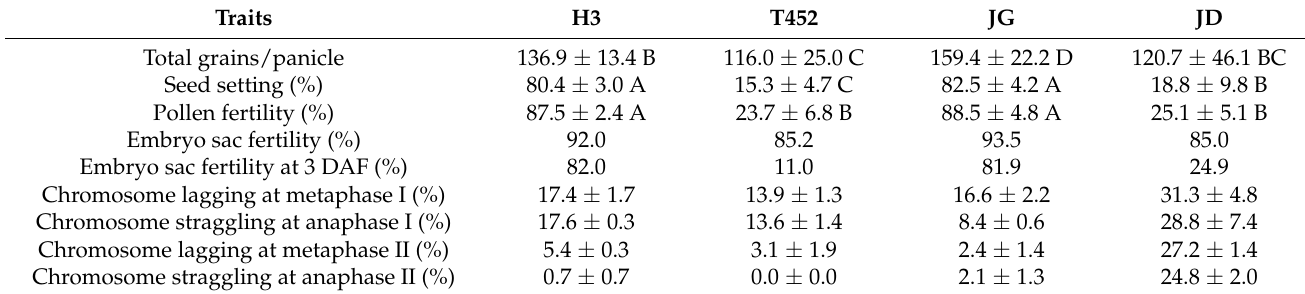
Figure 1. Phenotypic characterization of hybrid lines and their parents. ( a – d ) Plant morphology of H3, T452, JG and JD at mature stage. Bars = 10 cm. ( e – h ) Mature panicles of H3, T452, JG and JD (from left to right). Bars = 1 cm. ( i – l ) Pollen fertility of H3, T452, JG and JD. Bars = 50 µ m. Table 1. Agronomic traits of JG bulk, JD bulk and their parents during early and late seasons in